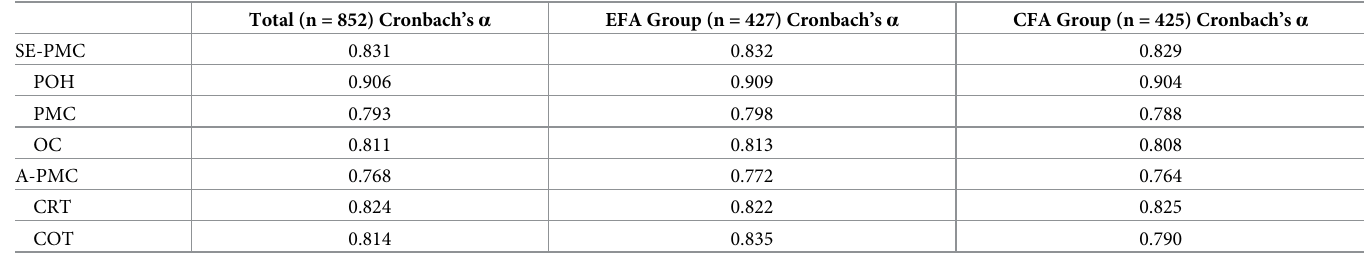
Table 4. Reliability analysis results of the Chinese version of SE-PMC and A-PMC (n = 852). Total (n = 852) Cronbach’s